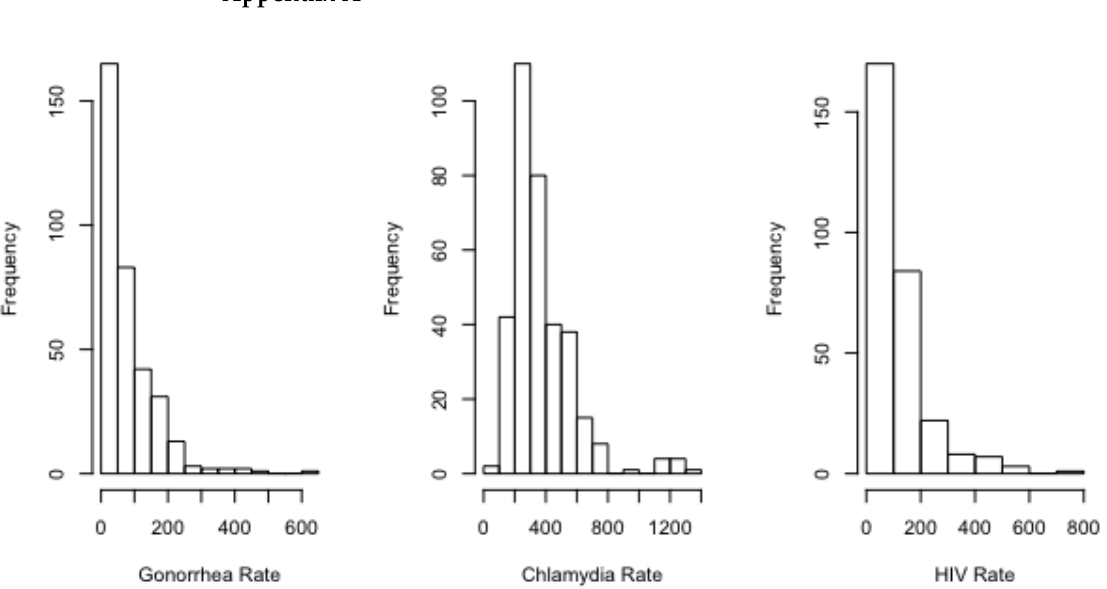
Figure A1. The distributions of urban county values of each of the response variables used in the model. A right skew is present for all sexually transmitted infections (STIs), with chlamydia demonstrating the least skew.